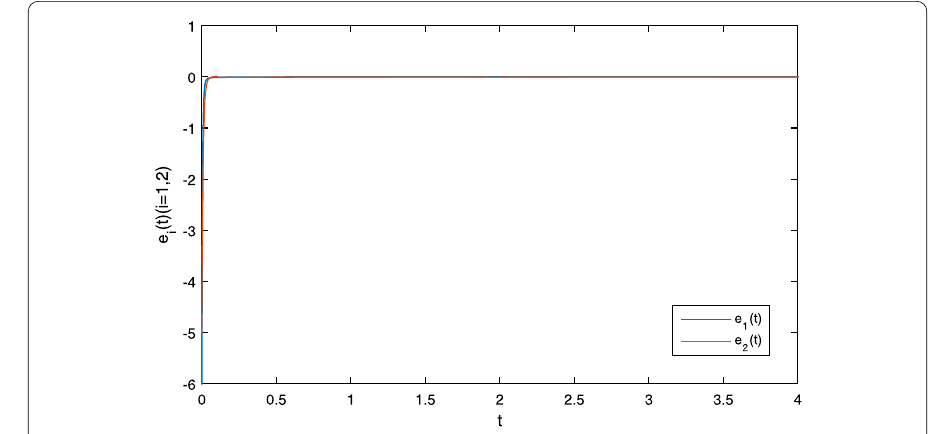
Figure 2 The synchronization errors e i ( i = 1,2) state with β = 2